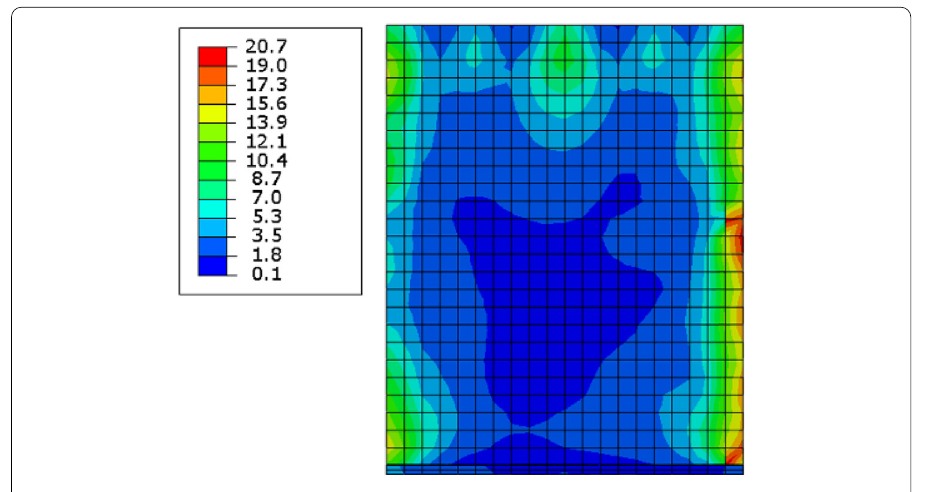
Fig. 8 Initial design feature model in (MPa)